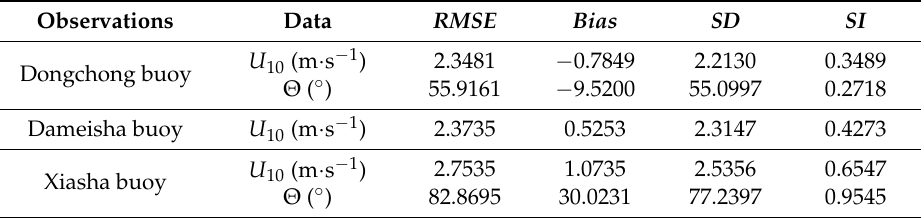
Table 6. Summary of the error indicators for the Typhoon Kalmaegi simulation.